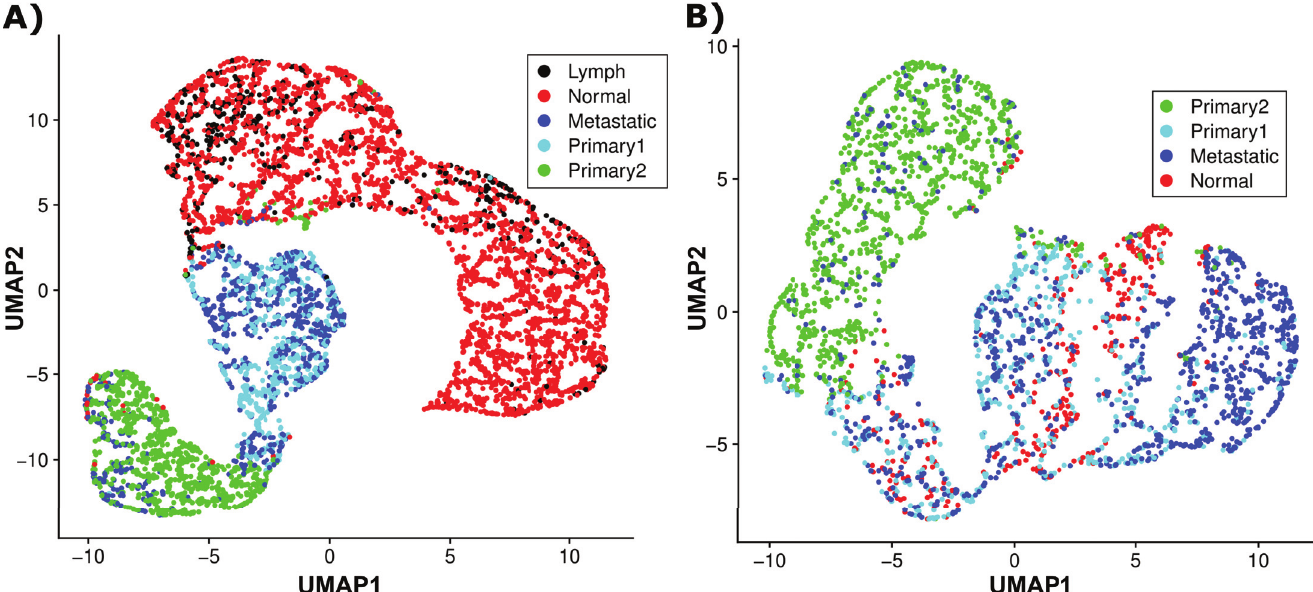
Fig 4. UMAP results for metastatic cancer SC-RNA-seq datasets. UMAP results for the two single-cell RNA-sequencing data sets: A . H&N data and B . ovarian data. Note: the primary tumor cells are colored based on the PCA sub-clustering in S9 Fig.